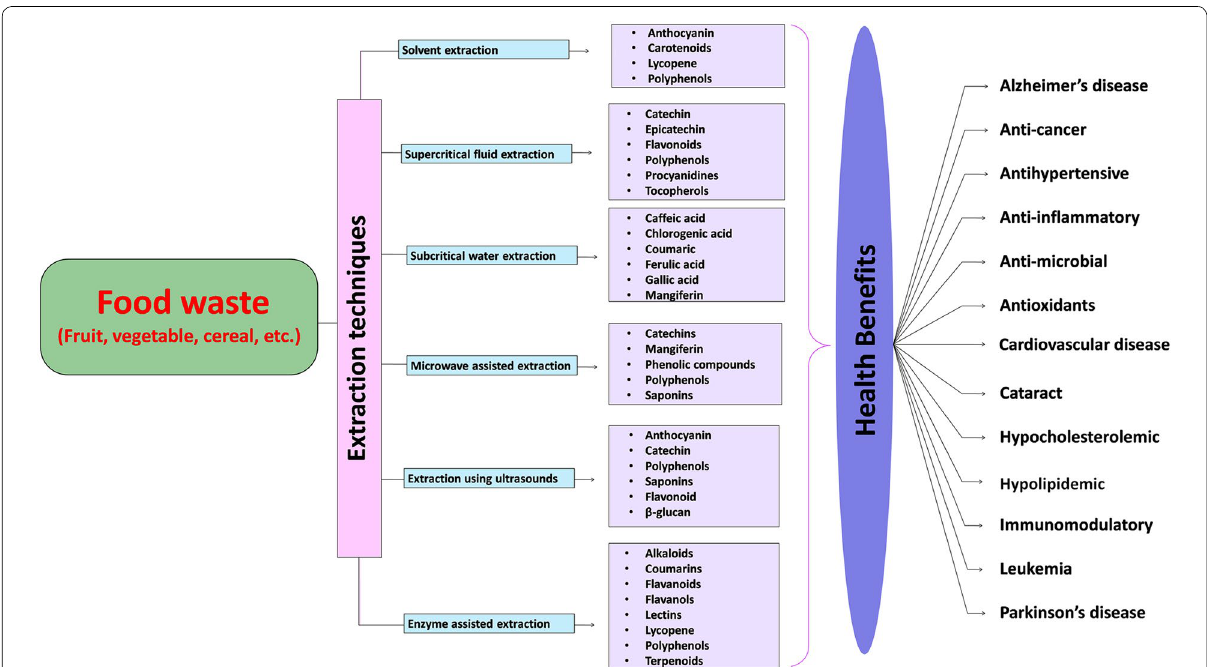
Fig. 1 A schematic representation of different techniques for extraction of bioactive compounds from food wastes and their health